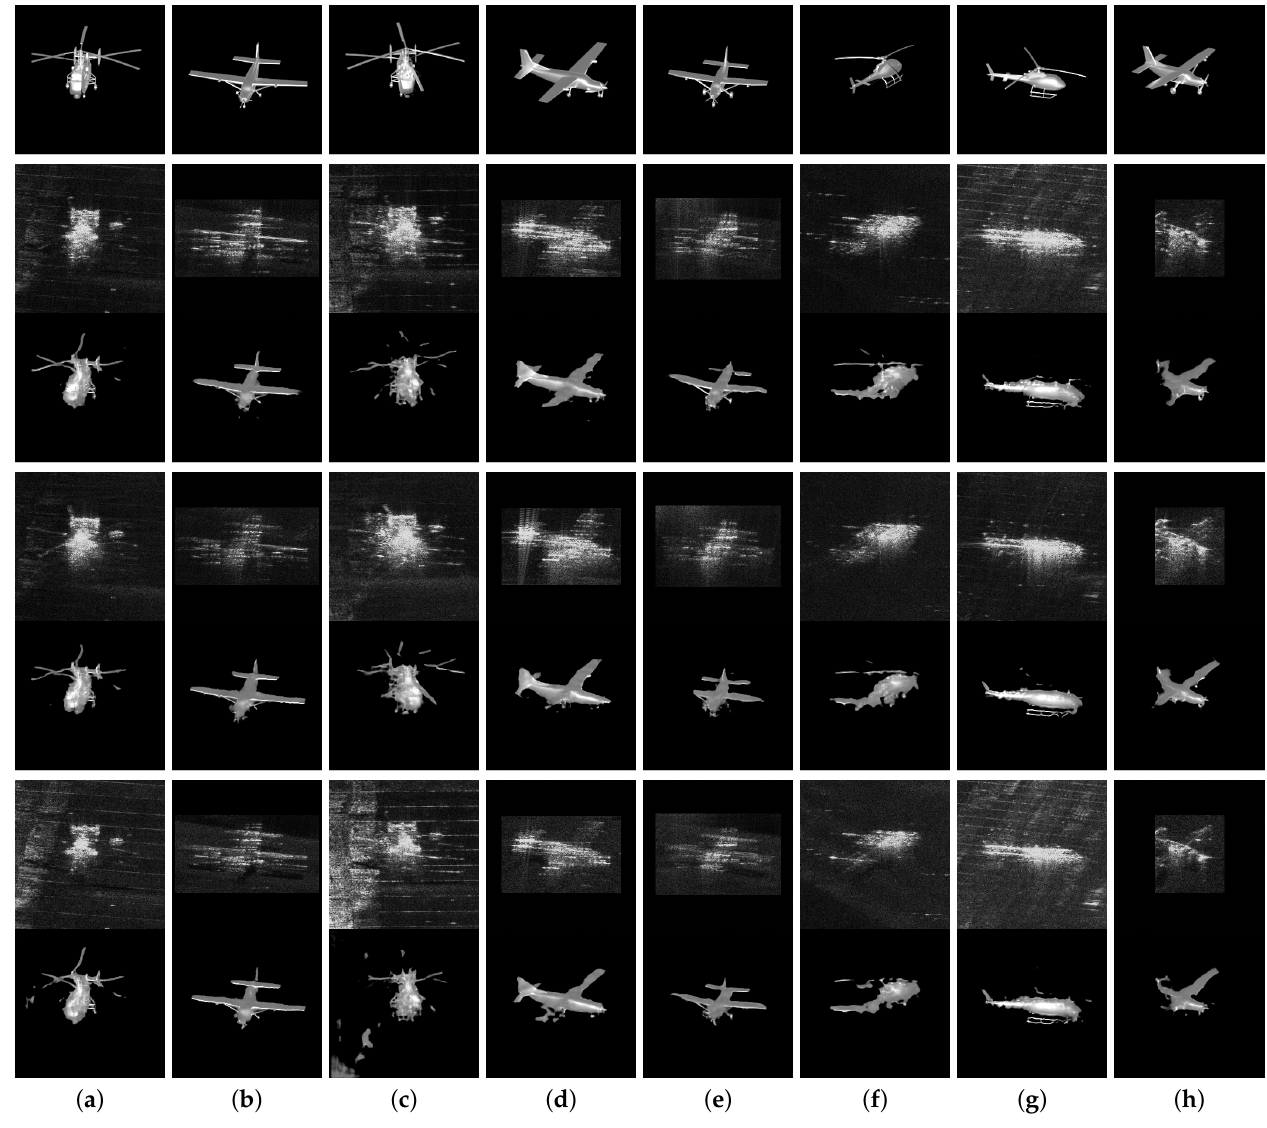
Figure 9. Examples of the failed cases. Columns ( a – h ) show the results of different categories, respectively. The first row shows optical images, then SAR images in HH, SAR images in HV, and SAR images in VV, each followed by corresponding translated